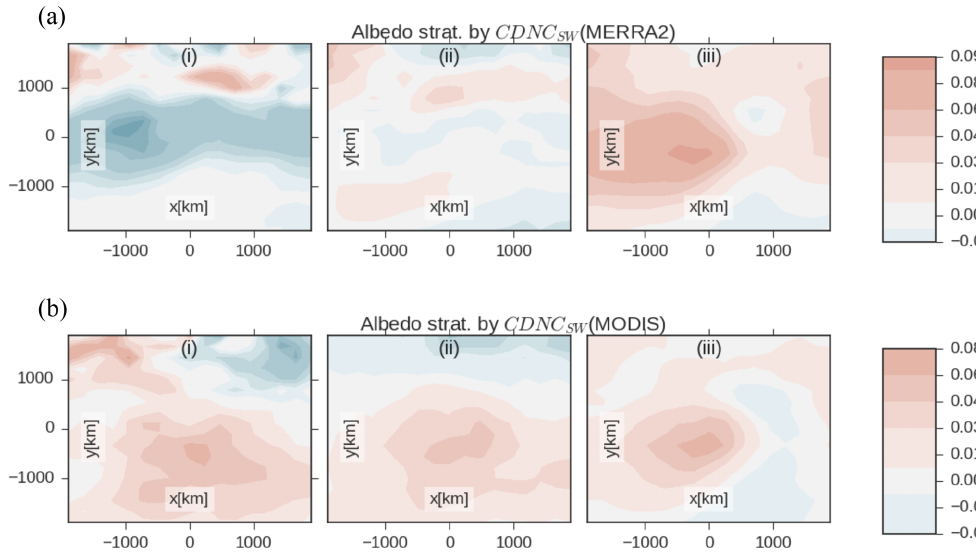
Figure 11. As in Fig. 7, but showing differences in albedo.